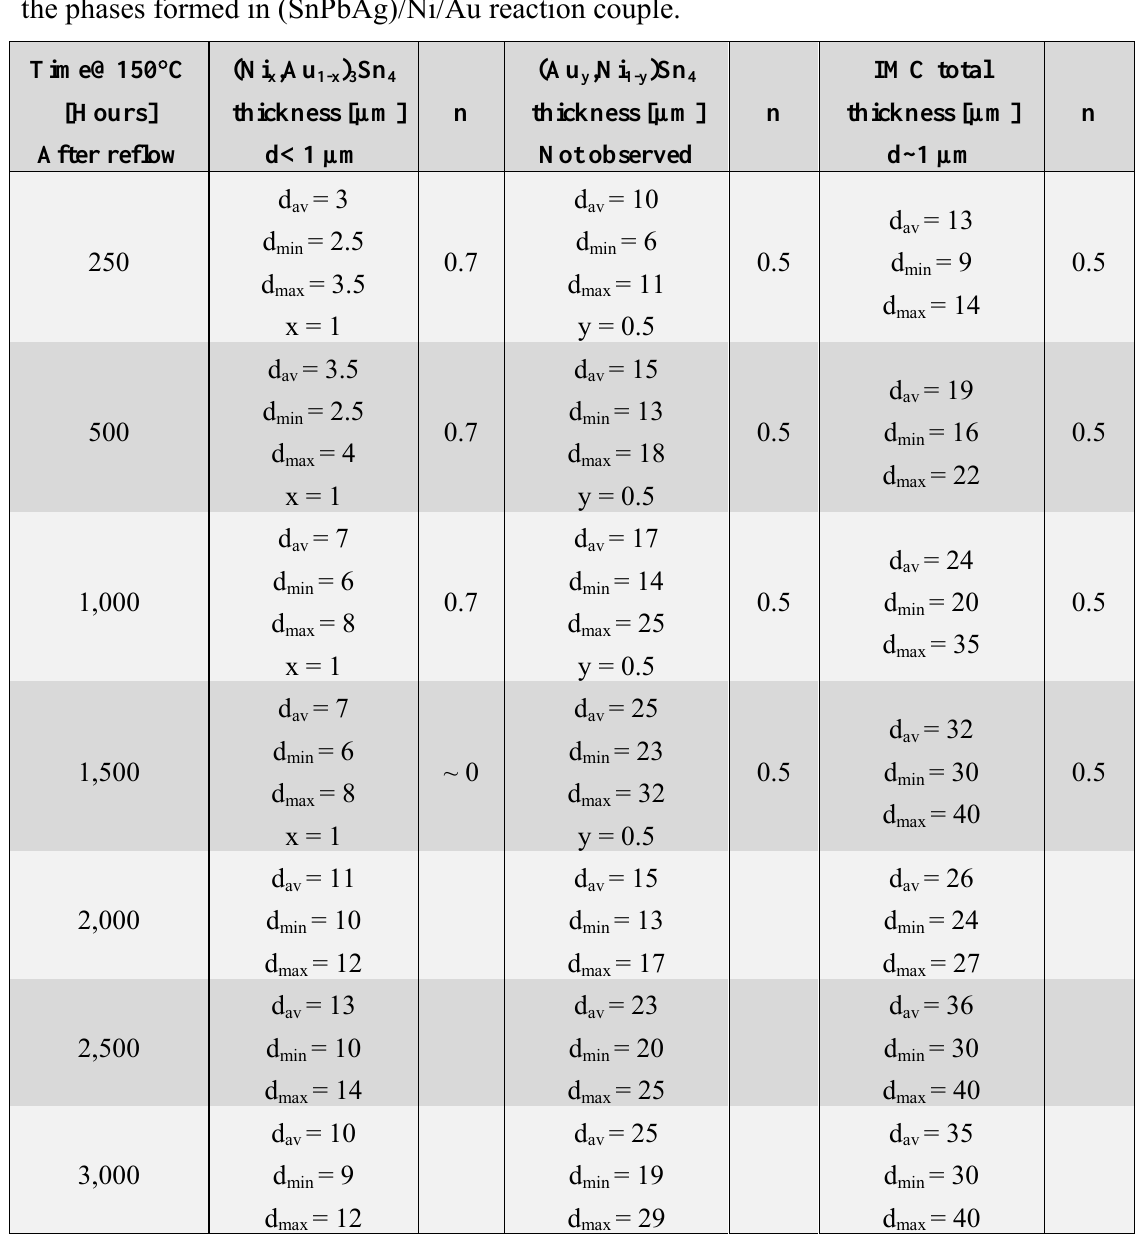
), maximum(d ) and average thickness (d min max